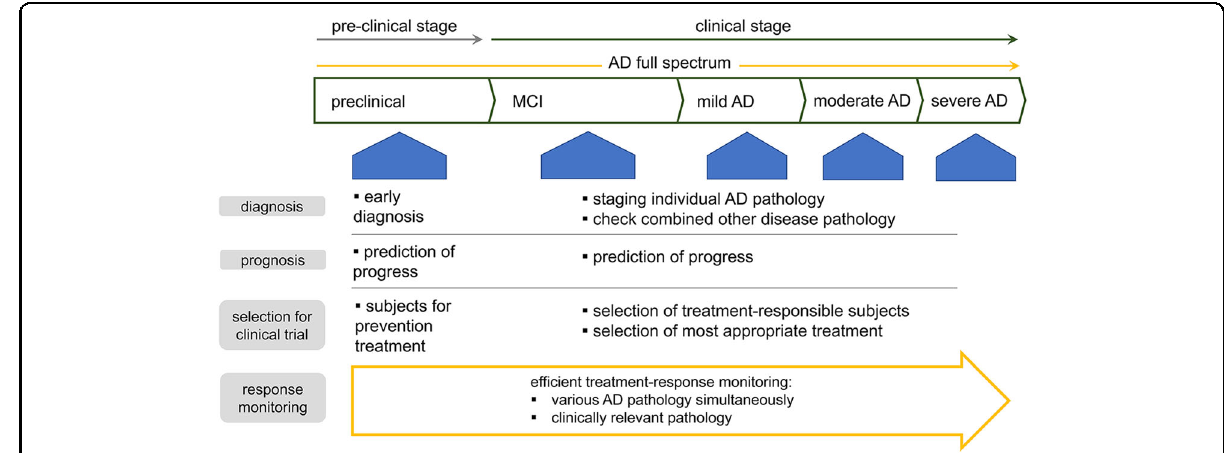
Fig. 3 Perspectives on future clinical utility of new biomarkers. AD, Alzheimer ’ s disease; MCI, mild cognitive